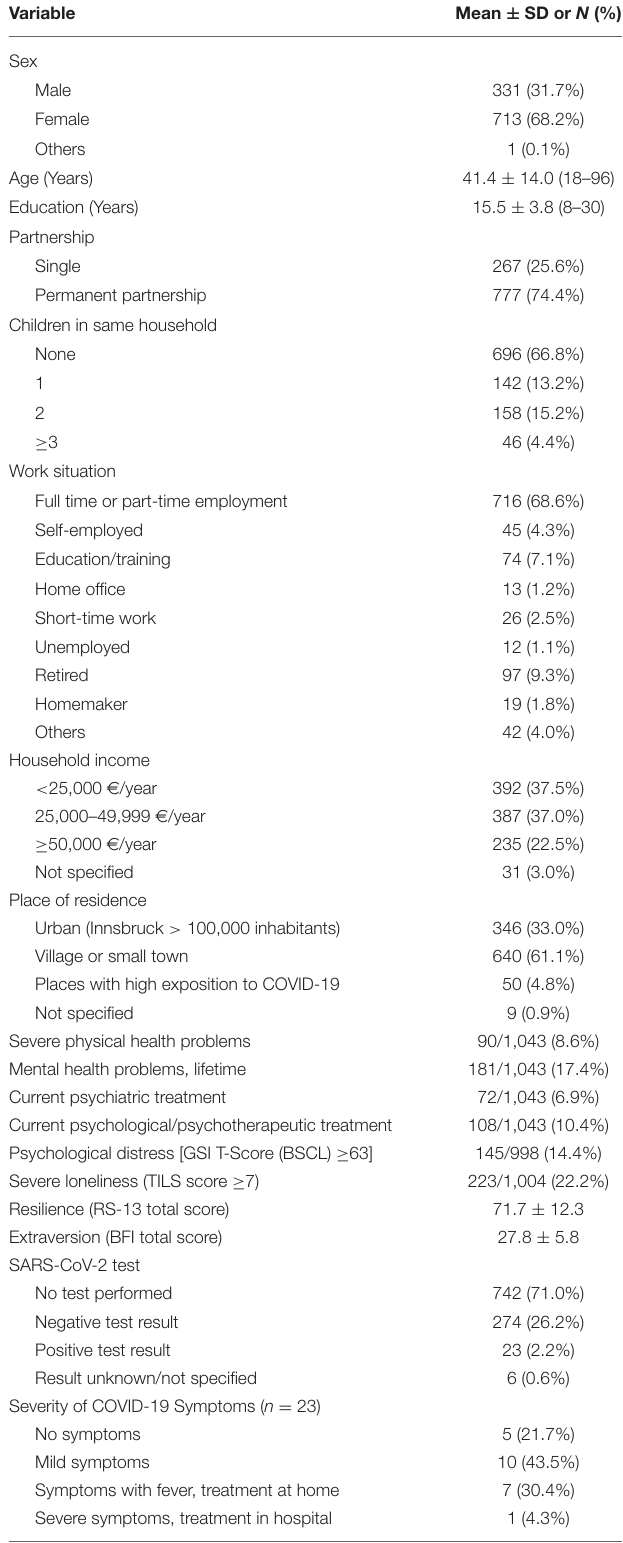
TABLE 1 | Sociodemographic and health-related variables ( N = 1,045).